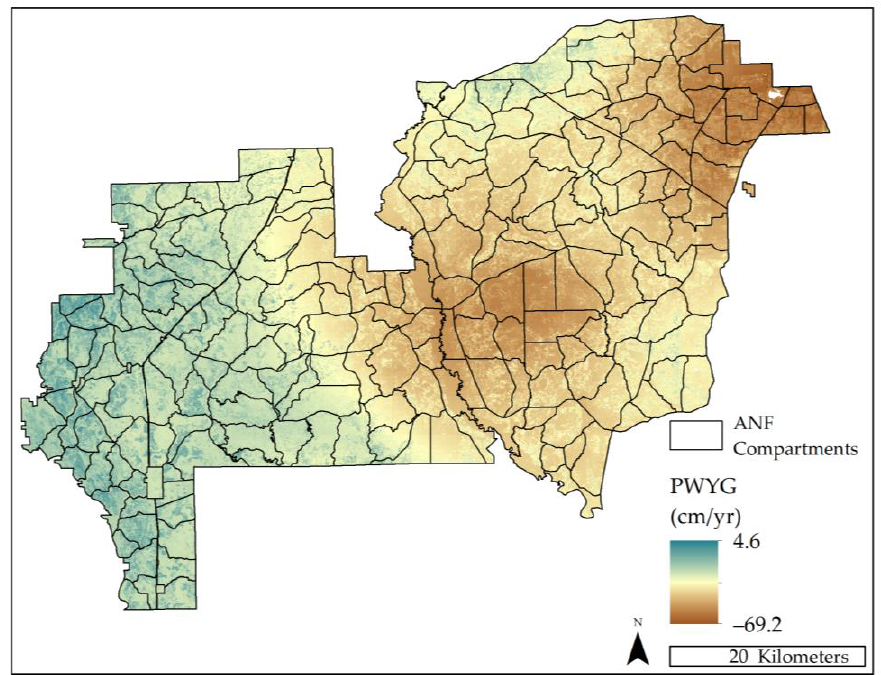
Figure 9. Gridded dataset showing potential water yield gain (or loss) in cm per year for the highest observed aridity pixel values at the ANF compartment level, in which timber thinning to a BA of 7 m 2 ha −1 is conducted in a climate scenario with persistent drought-like conditions.